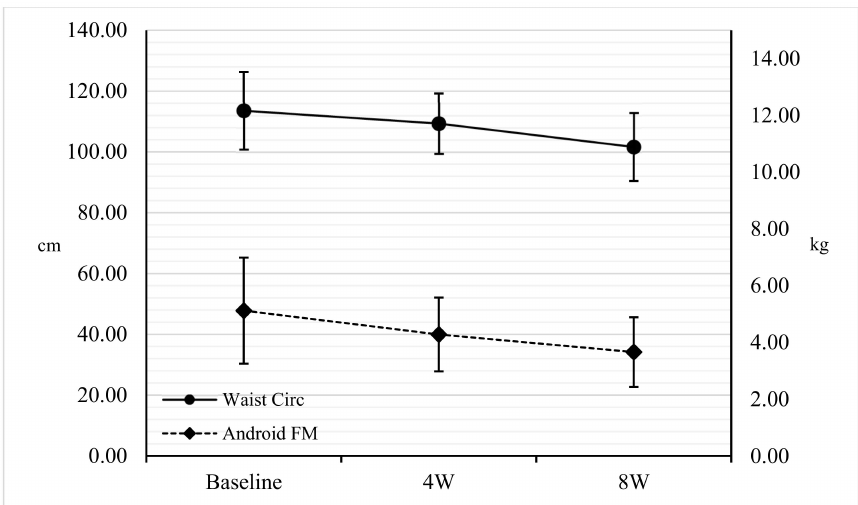
Figure 1. Comparison among baseline, four weeks, and eight weeks for waist circumference (cm) and android fat mass (kg). Points sharing the same superscript letter are not significantly di ff erent from each other. Statistical significance attributed to results with p < 0.05. Circ: Circumference. FM: Fat Mass; 4W: four weeks; 8W: eight weeks.